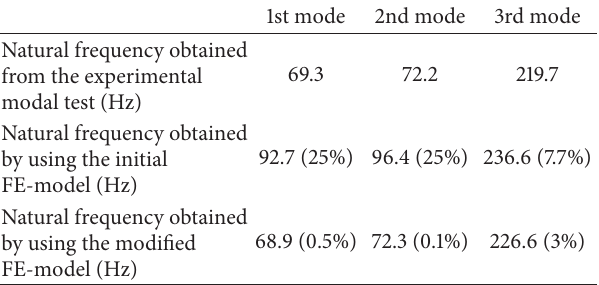
Figure 5: Accelerometers attached on the butterfly valve for the experimental modal test.